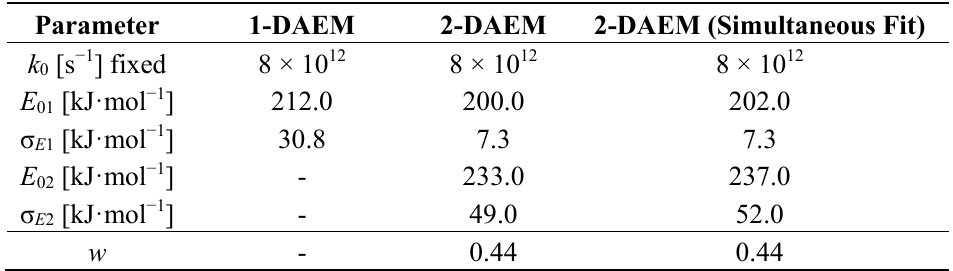
Table 5. Kinetic parameters obtained with the 1-DAEM and 2-DAEM at 100 K·min −1 for the Sulcis coal.